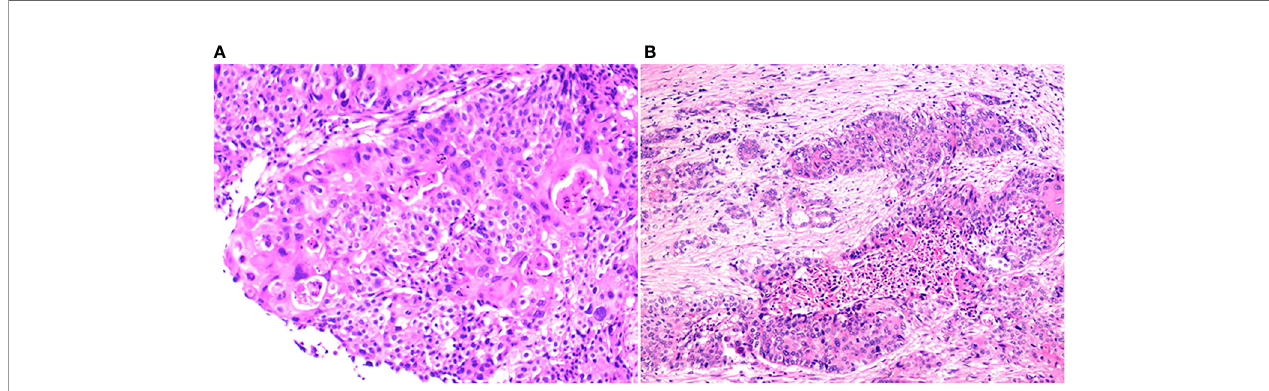
FIGURE 2 | Hematoxylin and eosin (HE) stain of the pancreaticlesion. (A) The biopsy of the pancreatic lesion for initial diagnosis indicated squamous cell carcinoma (200×). (B) The HE stain of the surgical sample after the combined chemotherapy